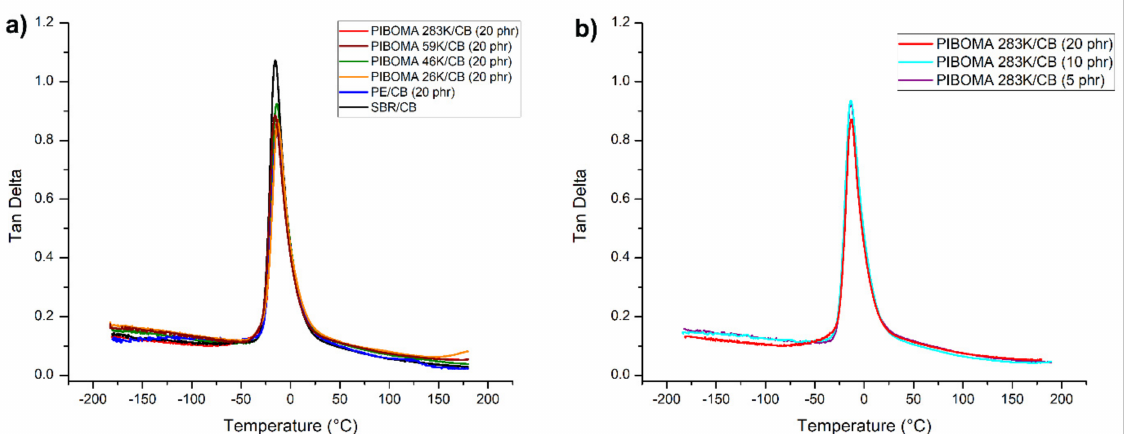
Figure 6. Tan δ as a function of temperature for vulcanized rubber compounds containing 50 phr of CB and and filled with 20 phr of PIBOMA 283 K and 20 phr of UHMWPE for comparison ( a ) and of those containing different amounts of PIBOMA 283 K ( b